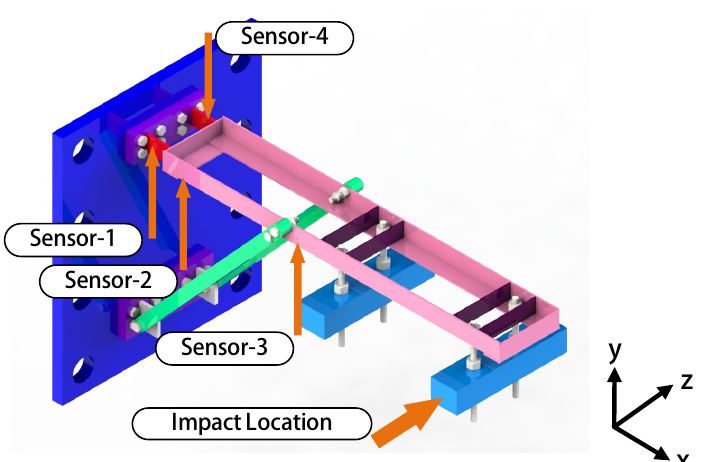
Figure 5. 3D model of the steel frame structure including the location of four sensors and impact load.